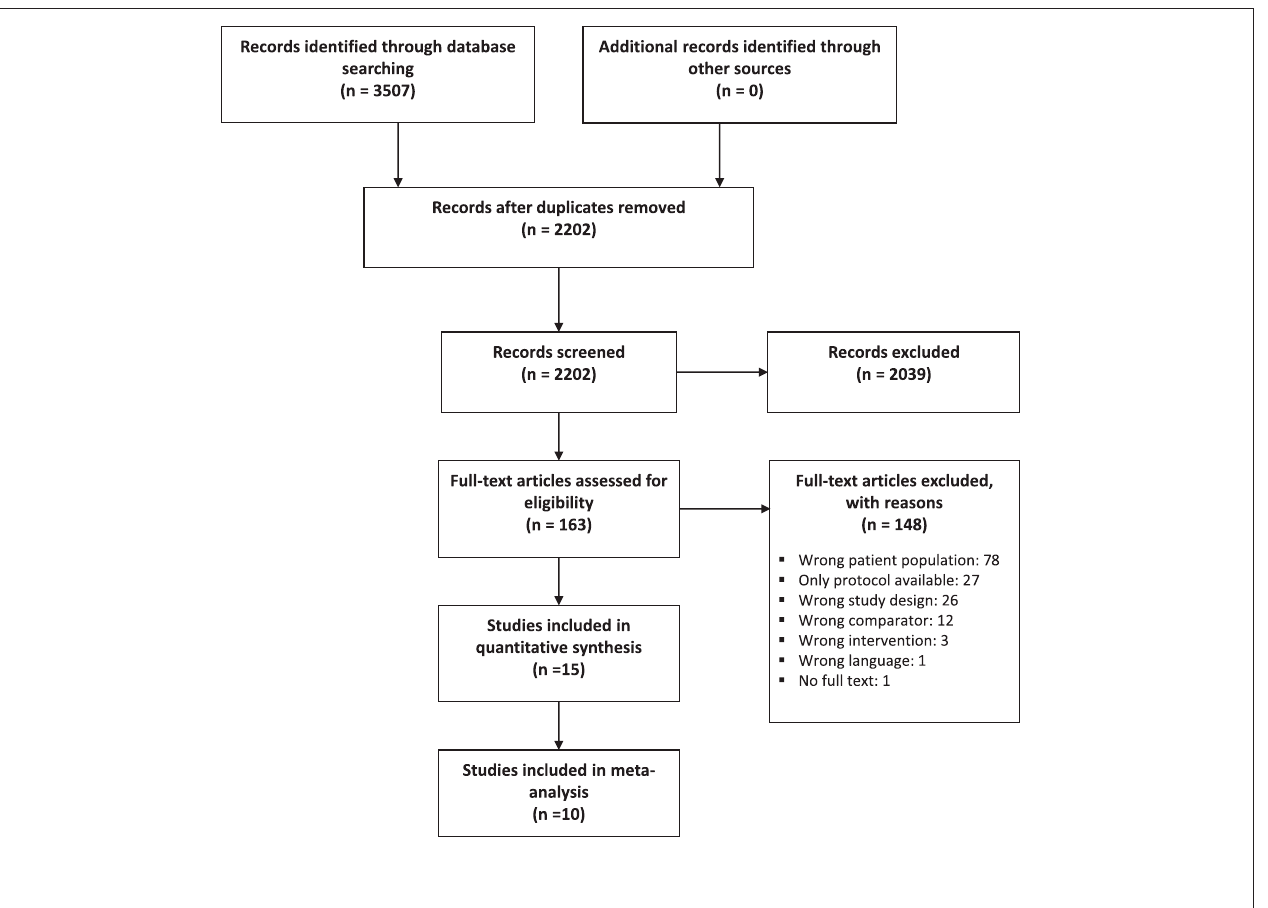
FIGURE 1 | The PRISMA flow diagram for the systematic review detailing the selection process of the included RCT